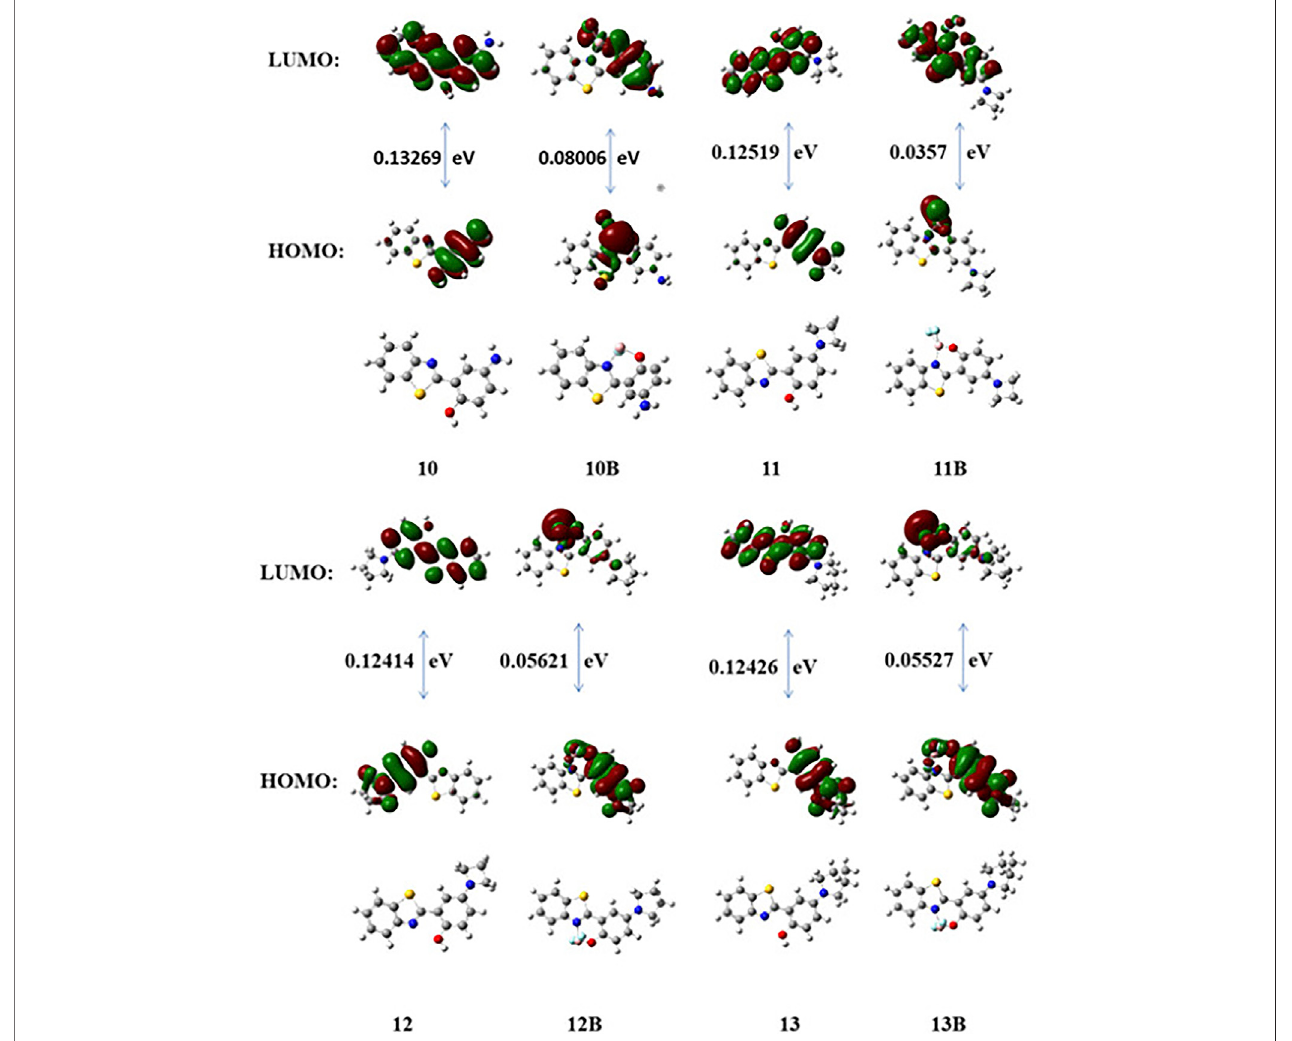
FIGURE4| DFToptimizedstructuresandmolecularorbitalplots(LUMOandHOMO)ofselected fl uorophoresbasedontheoptimizedground-stategeometry(S 0 ). In the ball-and-stick representation, carbon, nitrogen, and oxygen atoms are colored gray, blue, and red, respectively.